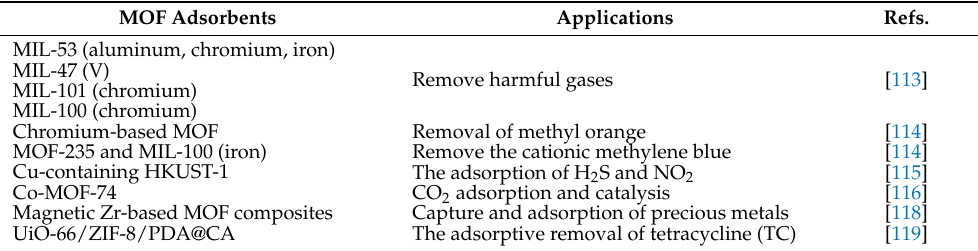
Table 2. Applications of MOFs for adsorption and degradation of VOCs. MOF